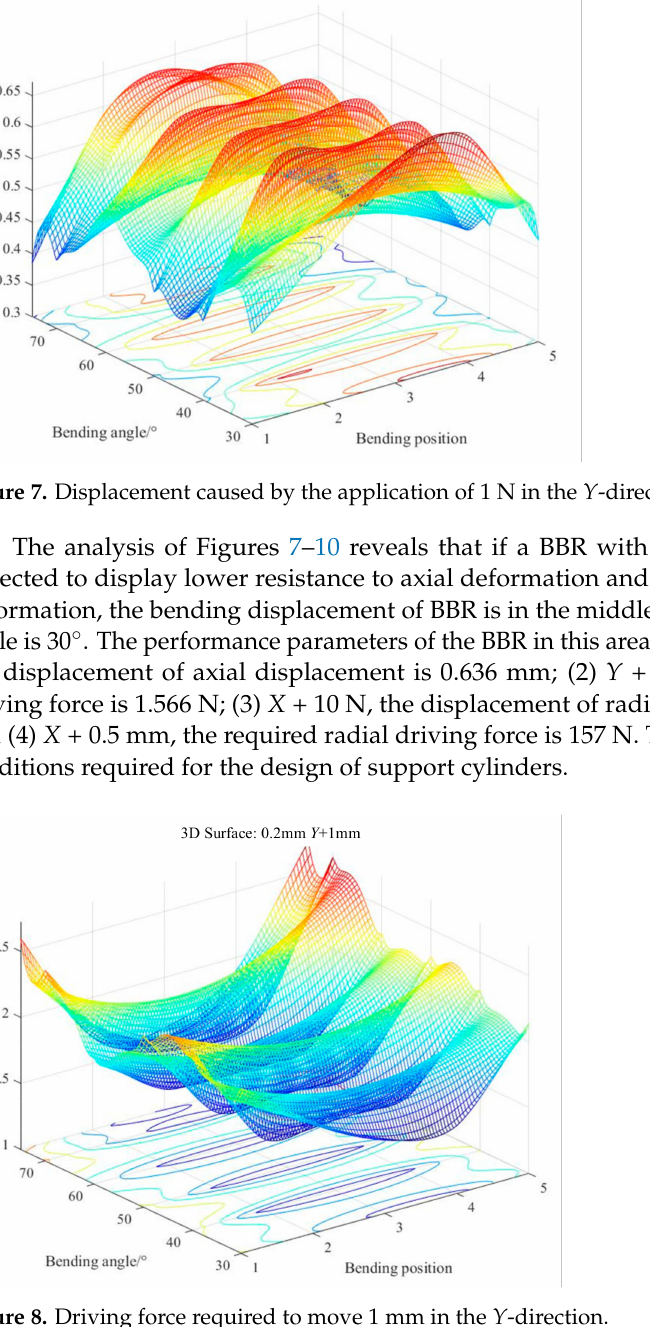
minimum displacement is approximately 0.05